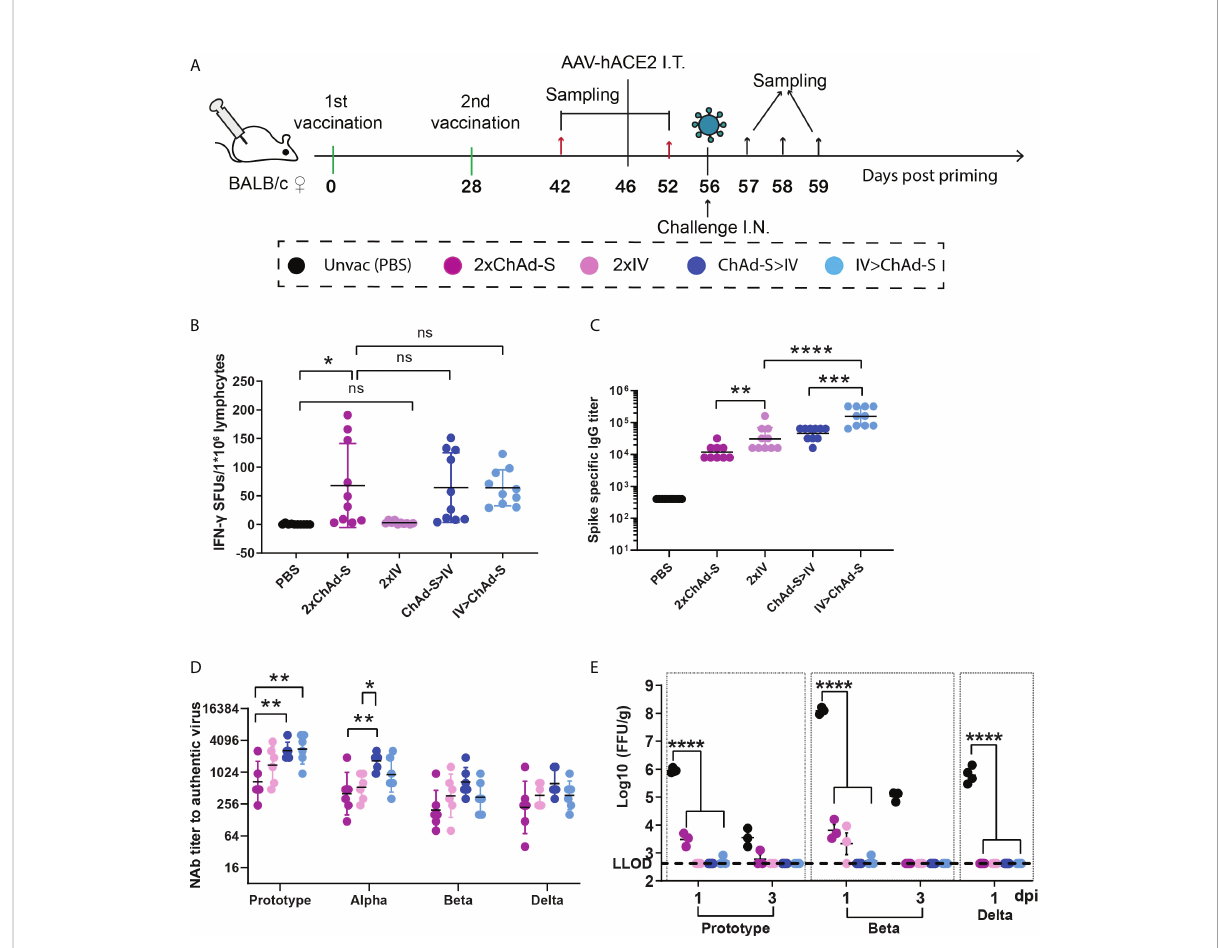
FIGURE 1 Immune responses and protective effect induced by homologous or heterologous prime-boost with ChAd-S and IV in mice (A) . Schematic representation of experimental protocol. Mice in 4 groups were immunized with different vaccines: 2×ChAd-S, 2×IV, ChAd-S>IV, IV>ChAd-S. Unvac group were injected with PBS. N=16 per group. (B) Splenocytes on day 42 were stimulated with spike peptide pool, and the IFN- g secreting cells were quanti fi ed by ELISPot assay and expressed as spot forming units (SFU). N=10 per group. (C) Serum spike speci fi c IgG titers were measured by ELISA on day 42. N=10 per group. (D) Serum NAb titers measured by live SARS-CoV-2 virus were expressed as 50% inhibitory dilution (EC50) of serum. N=6 per group. (E) . Lung viruses were quanti fi ed by a focus reduction neutralization test and expressed as FFU/g. N=6 per group, one spot represents one animal. One-way ANOVA was performed for (B – E) Bars represent the geomean ± geometric SD for c and d, mean± SD for (B, E) ns: p>0.05, *p<0.05, **p<0.01, ***p<0.001,